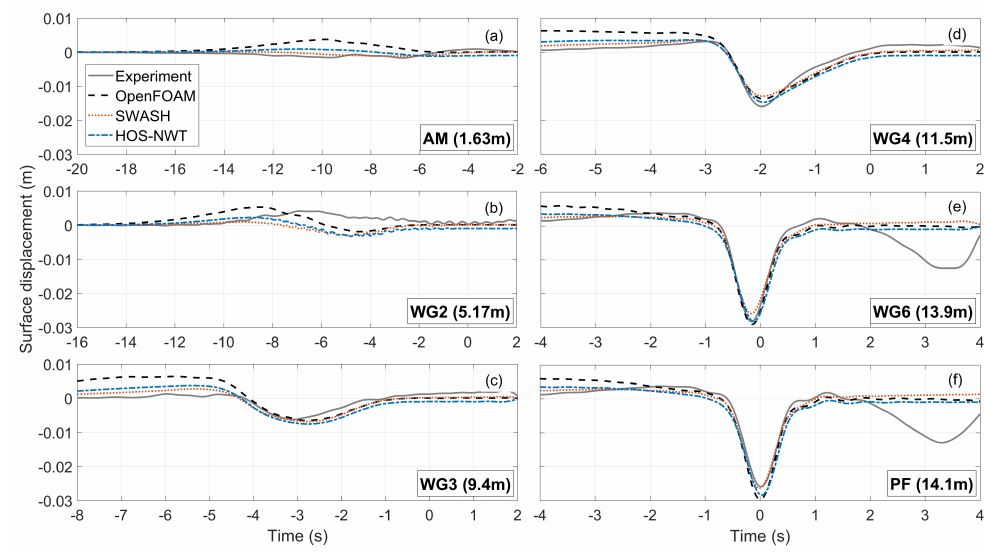
Figure 10. Comparison of the free surface elevation of the 2 nd order difference harmonics between the numerical models and the experiment at different locations ( a – f